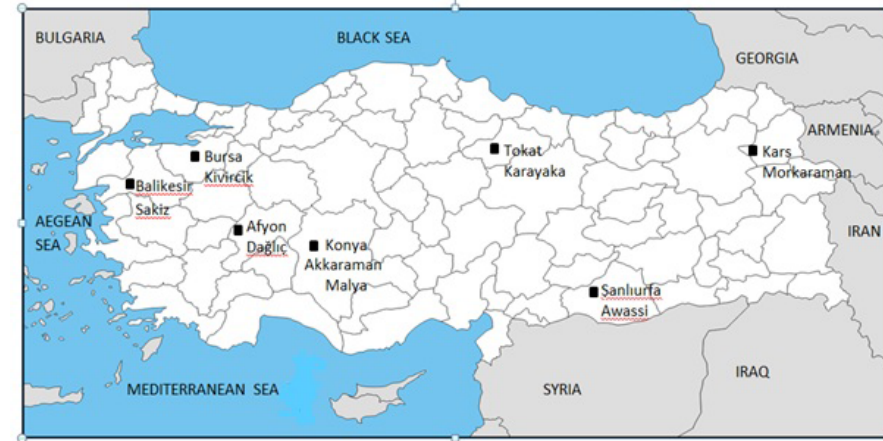
Figure 1. The location of the samples used for DNA sequencing (drawn by Fatma ˙Ihan).